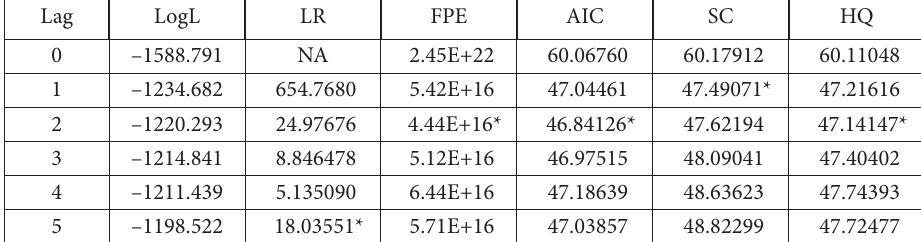
Table A2. Lag length criteria in the case of the model for Czech Republic (source: authors’ calculations)